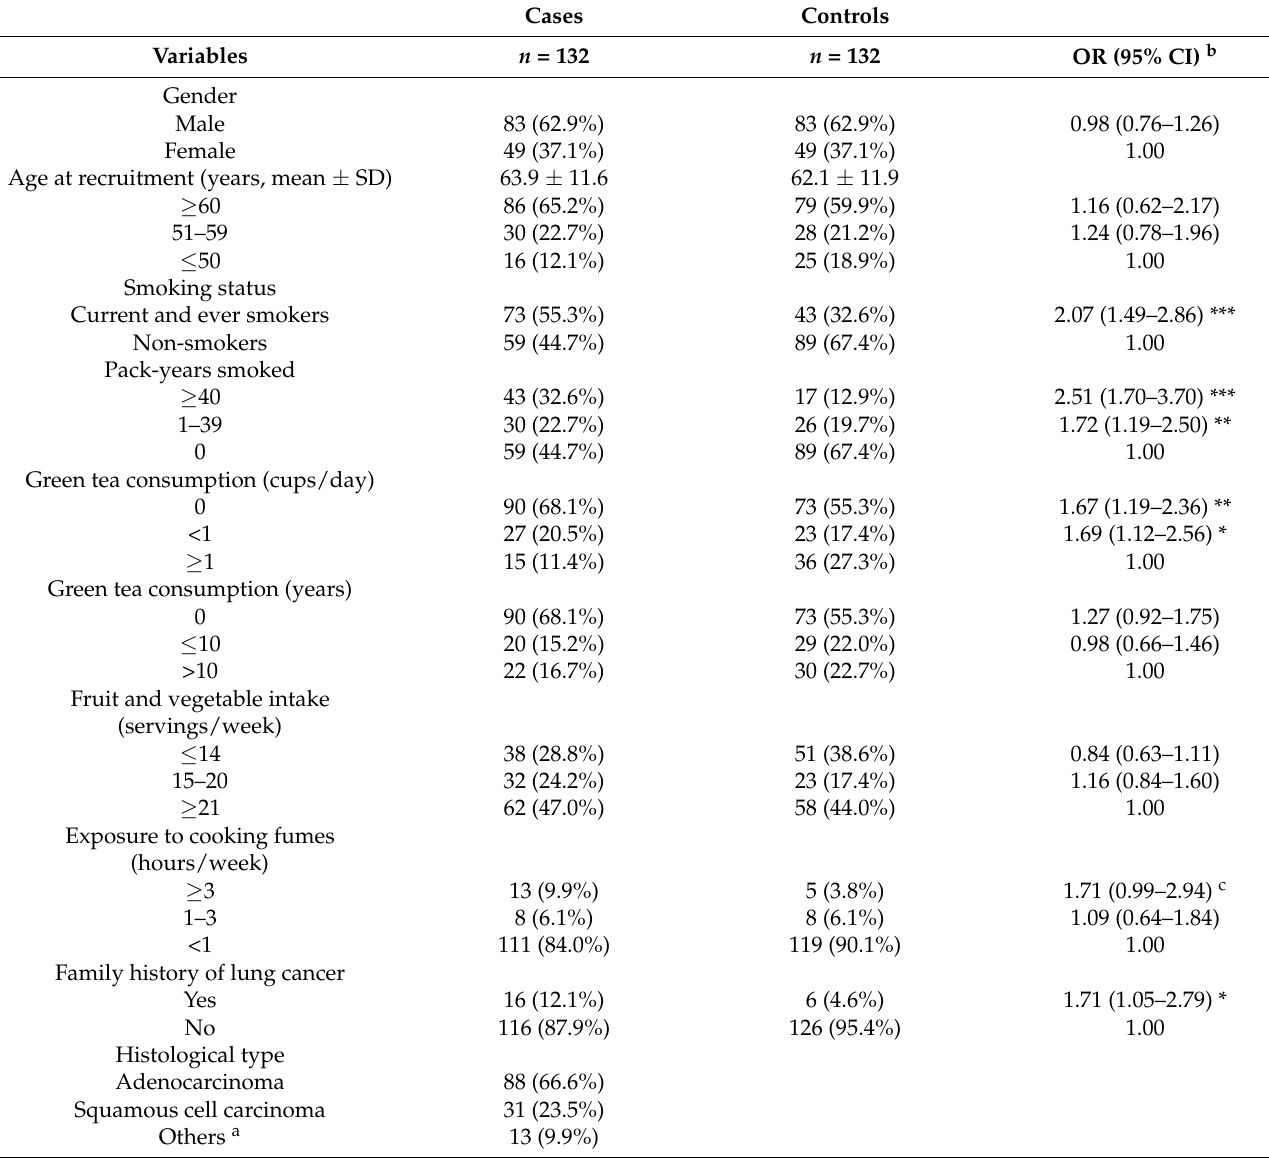
Table 1. Basic characteristics of lung cancer patients and